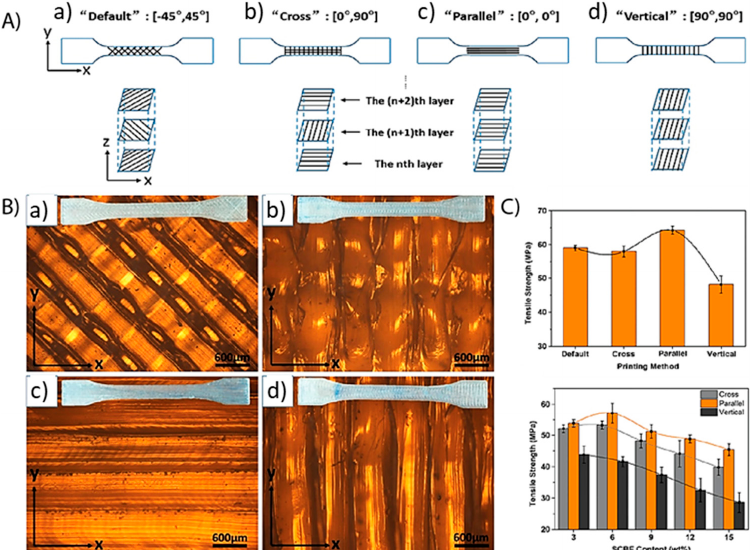
Figure 5. E ff ect of infill and printing orientation patterns including (a) default, (b) cross, (c) parallel, and(d)vertical. ( A )Graphicalrepresentationoftheseprintingorientationofinfilllayers.( B )Infillpattern images using atomic force microscopy (AFM). ( C ) Tensile strength of PLA composites printing using various infill patterns. Reprinted from [91] by permission from John Wiley and Sons. Copyright